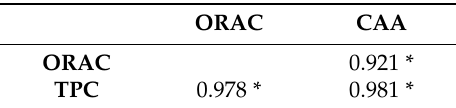
Table 2. Correlation analysis among antioxidant activity parameters measured in raspberry juices and stevia crude extract. * indicates significance at p < 0.005 according to t -test.